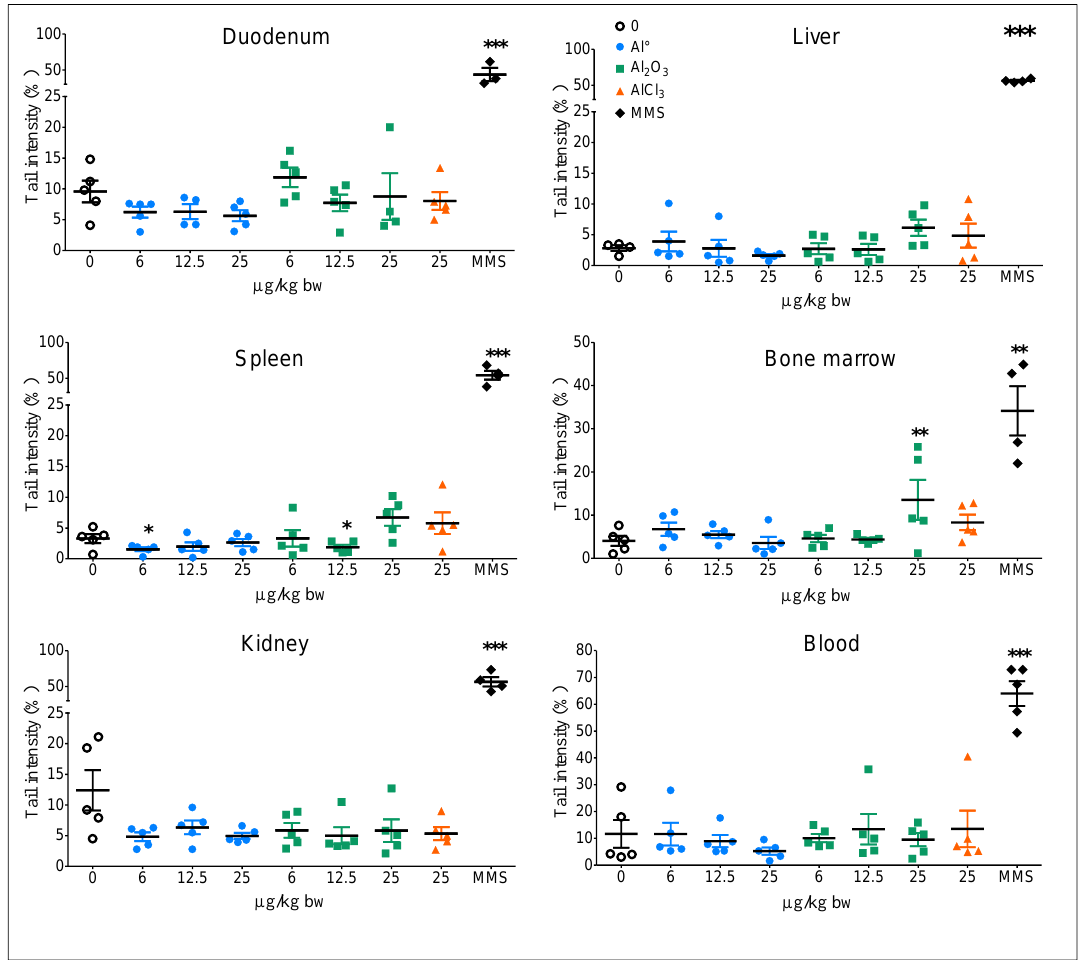
Figure 1. DNA damage in organs / tissues of rats orally exposed to Al 0 NMs, Al 2 O 3 NMs or AlCl 3 . A group treated with the vehicle (0, negative control) and a group treated with a genotoxic agent (MMS, positive control) were included. Significant from control at ** p < 0.01, *** p < 0.001.